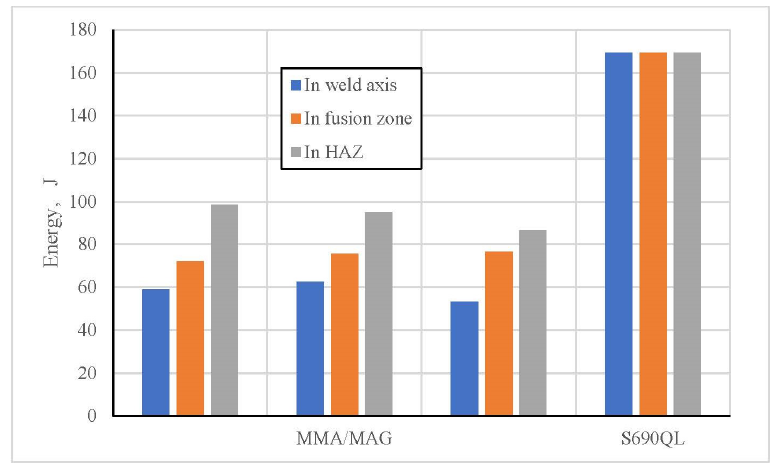
Figure 8. Fracture energy histogram of the test samples with a notch on the face side of the welds.